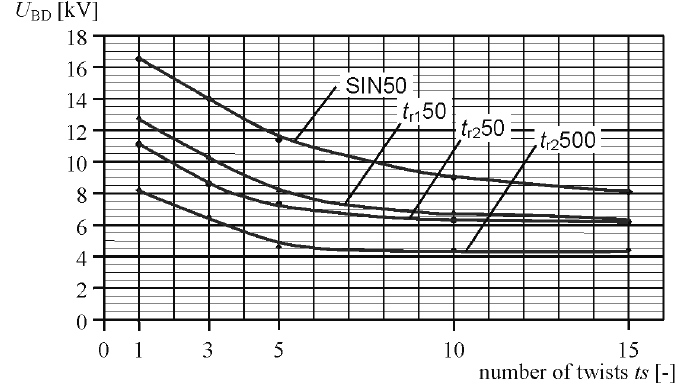
Figure 7. The dependence of breakdown voltage U BD of TP0.3C samples on number of twists ts at semi-square voltage SSV with rise time: (1) t r1 , 50 Hz, (2) t r2 50 Hz, (3) t r2 500 Hz and (4) voltage VSIN50. Energies 2018 , 11 , x FOR PEER REVIEW 7 of 19 Figure 8. The dependence of breakdown voltage U BD of TP0.8CC samples on number of twists ts at semi ‐ square voltage SSV with rise time: t r1 , (1) 50 Hz, (2) t r2 50 Hz, (3) t r2 500 Hz and (4) voltage VSIN50.